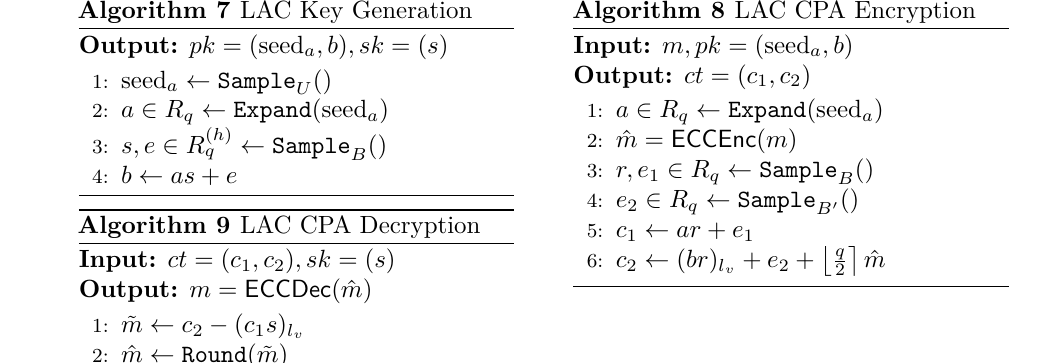
Algorithm 7 LAC Key Generation